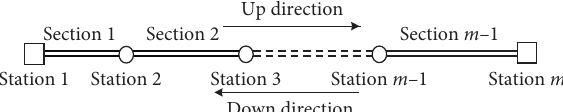
Figure 1: A high-speed railway corridor with double